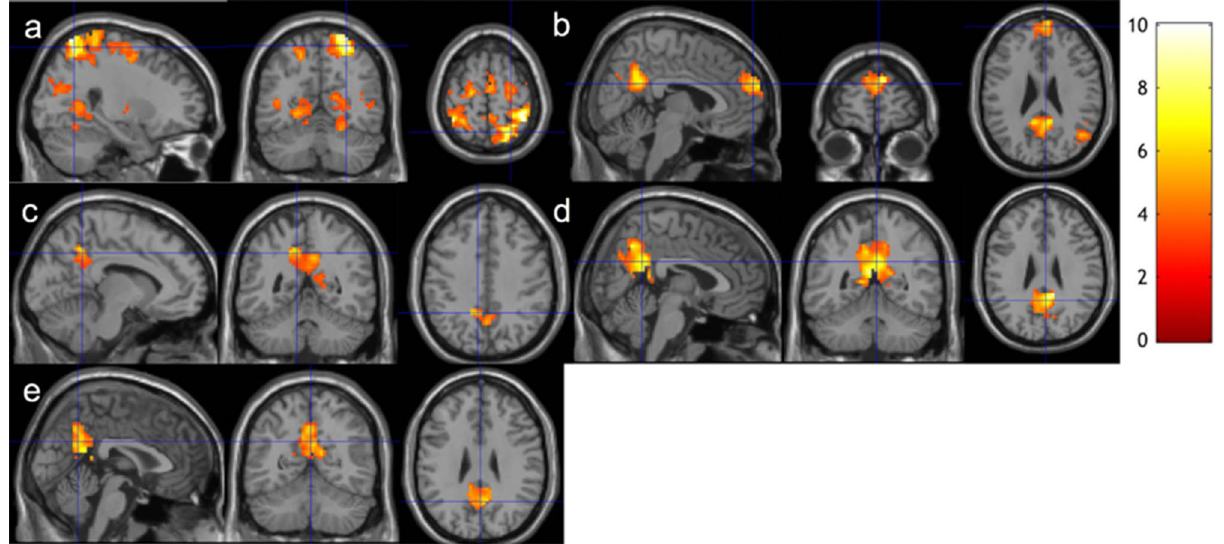
Figure 3. Increased functional connectivity from baseline to follow-up using the BOLD signal time series with conventional denoising . Regions overlaid on a standard brain template in which significantly increased functional connectivity was observed with a seed ROI at the (a) PCC, (b) RMT, (c) LMT, (d) RSPL, (e) LSPL regions after 2-month meditation training at the thresholds of a voxel-level p-value of 0.005 and corrected cluster-level p-value of 0.05. The color bar shows the range of t-values. PCC posterior cingulate cortex, RMT right medial temporal cortex, LMT right medial temporal cortex, RSPL right superior parietal lobule, LSPL left superior parietal lobule.